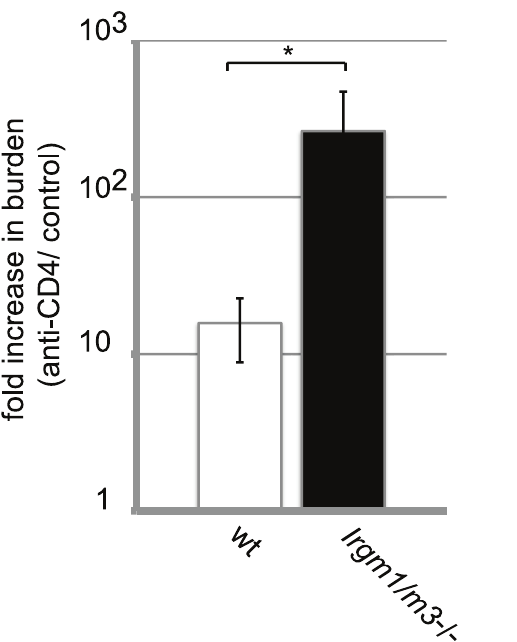
Figure 7. Dependency on the CD4 + T cell response for clearing intrauterine C.trachomatis infections is increased in Irgm1/m3 (-/-) mice. Groups of wildtype B6 and Irgm1/m3 (-/-) mice were treated with either ant-CD4 depleting or control antibodies as described in Materials and Methods. At 15 days post-infection mice were sacrificed and bacterial burden in the uteri was determined by qPCR. The fold increase in bacterial burden following treatment with anti-CD4 antibody compared to control antibody-treated mice is shown. The increase in burden in anti-CD4-treated Irgm1/m3 (-/-) mice was significantly higher than in wildtype mice (*, p , 0.05). Data are representative of three independent experiments.